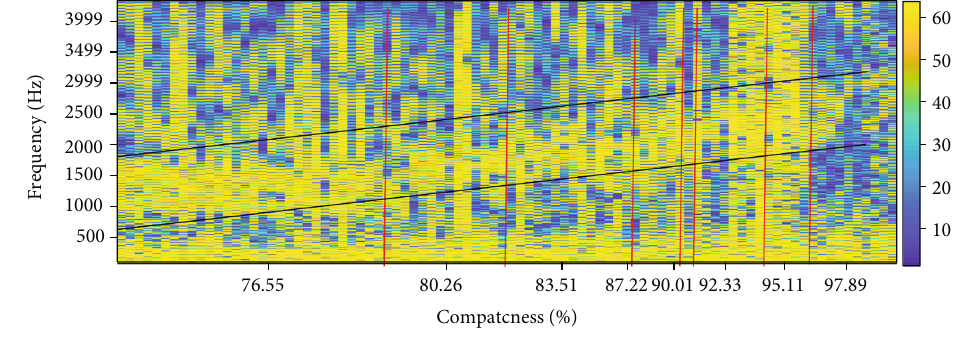
Figure 6: Frequency spectrum after 35(L) N hammering force is reduced by one-sixth.